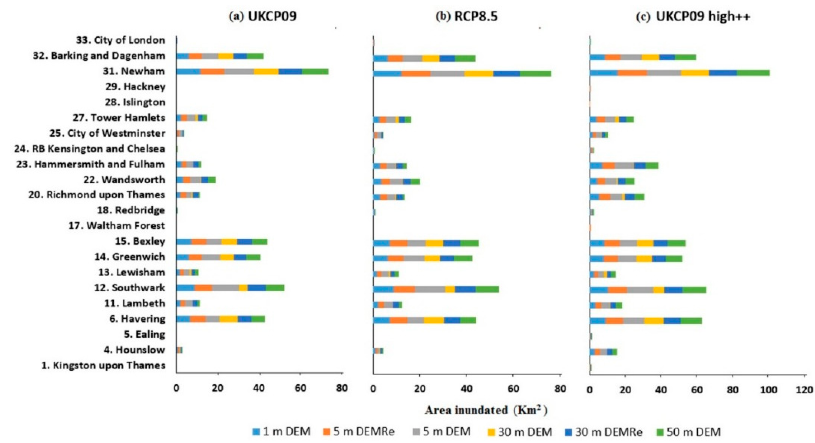
Figure 3. Inundation areas estimated for Greater London boroughs (km 2 ) obtained from an eight-way connectivity method using six different DEMs and three SLR scenarios: ( a ) 0.68 m UKCP09; ( b ) 0.82 m RCP 8.5; and ( c ) 1.9 m UKCP09 High++.